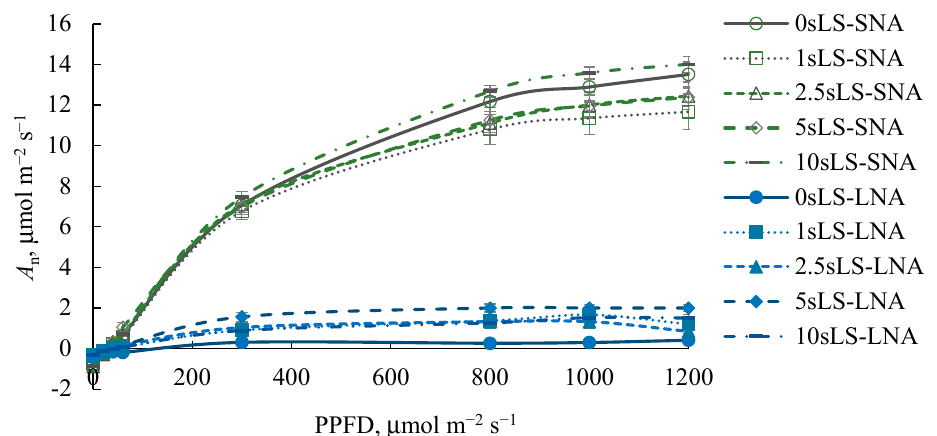
Figure 3. Light response curves of leaf CO 2 gas exchange of cucumber seedlings grown on the sandy loam soil with a sodium lignosulfonate concentration of 0 (0sLS), 1 (1sLS), 2.5 (2.5sLS), 5 (5sLS), and 10 (10sLS) vol % under sufficient nutrient availability (SNA) or low nutrient availability (LNA).